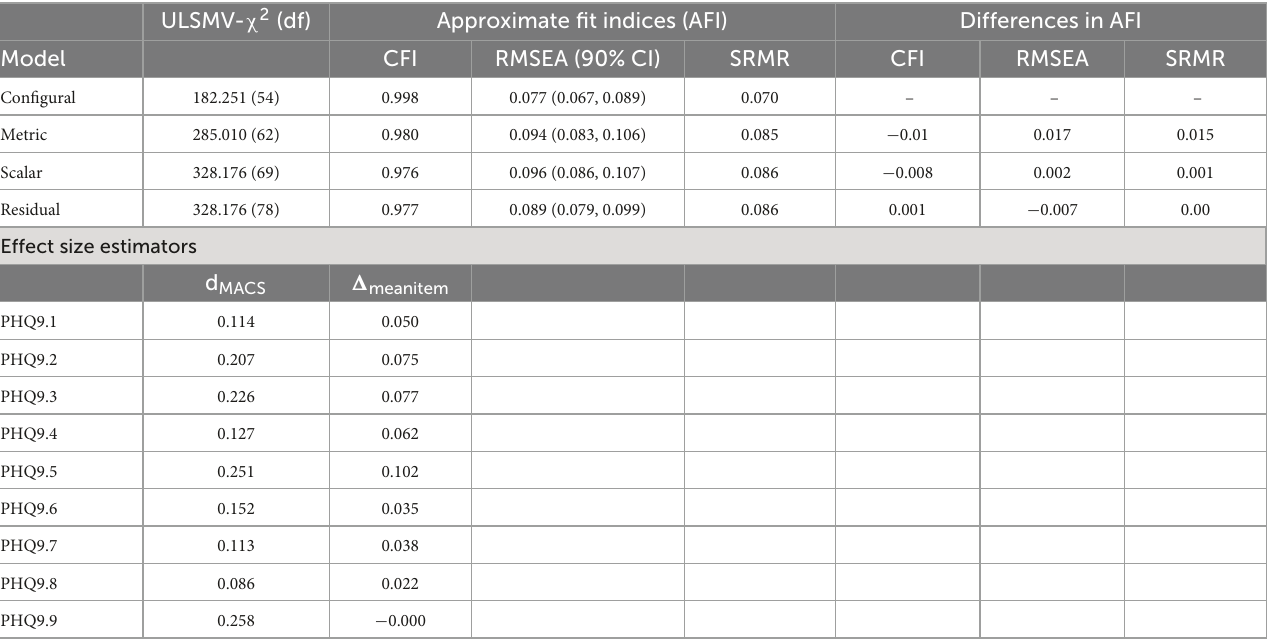
TABLE 6 Measurement invariance and effect size (d MACS